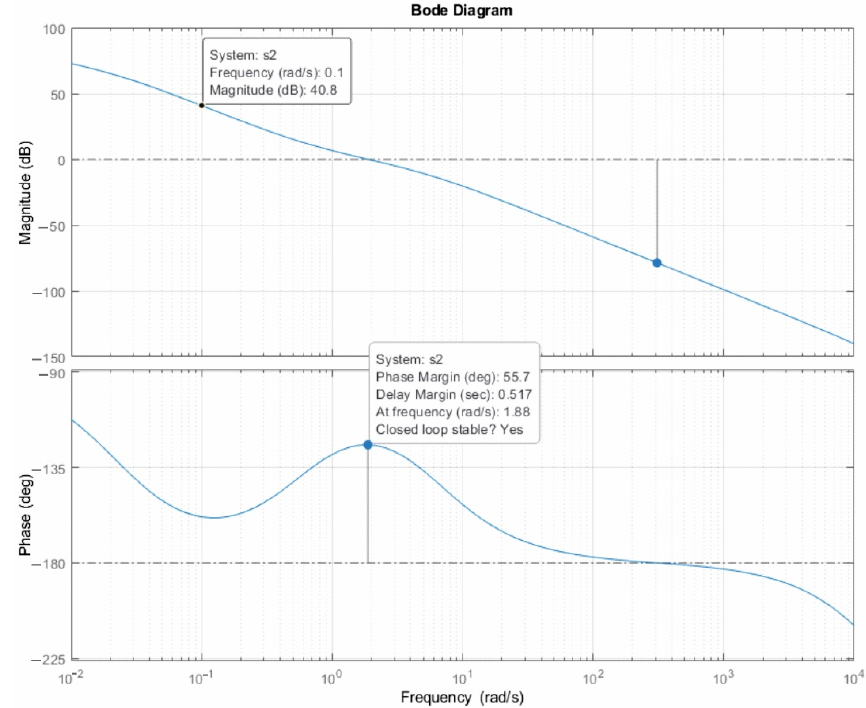
Figure 21. Bode characteristic of the system after applying phase advance. The controller includes a low-pass filter of the 2nd order with transmission, which allows the suppression of signal noise in the high-frequency range, Equation (18) and Figure 22.